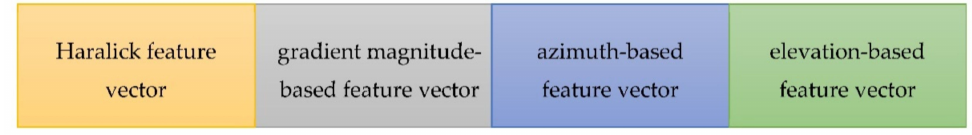
Figure 9. Final feature vector